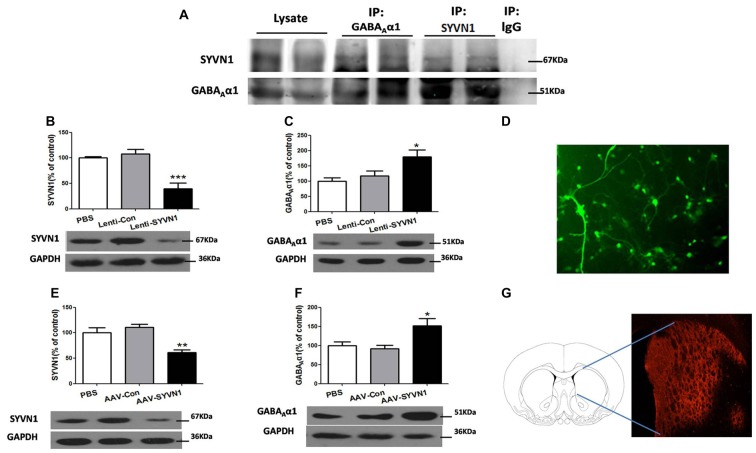
SYVN1 was associated with GABAAα1 degradation. (A) GABAAα1 co-precipitated with SYVN1. Lysates from Dstr were subjected to co-immunoprecipitation (Co-IP) using an anti-GABAAα1 antibody followed by western blotting with SYVN1 or GABAAα1 antibody. In reverse IP, lysates were immunoprecipiated with an anti-SYVN1 antibody followed by western blotting with GABAAα1 or SYVN1 antibody. (B) The SYVN1 expression level was significantly reduced in primary striatum neurons transfected with the Lenti-SYVN1. (C) Knockdown of SYVN1 by Lenti-SYVN1 increased GABAAα1 protein level in primary striatum neurons. (D) Representative image of in vitro lentivirus-infected primary neurons visualized by fluorescence microscope. (E) The SYVN1 expression level was significantly reduced in rat Dstr transfected with the adeno-associated virus (AAV)-SYVN1. (F) Knockdown of SYVN1 by AAV-SYVN1 increased GABAAα1 protein levels in rat Dstr. (G) Representative image of in vivo AAV-infected Dstr visualized by fluorescence microscope. Error bars represent mean ± SEM, n = 4–6 in each group. ***p < 0.001, **p < 0.01, *p < 0.05 compared with the corresponding control groups, one-way analysis of variance (ANOVA) with Newman-Keuls post hoc test.